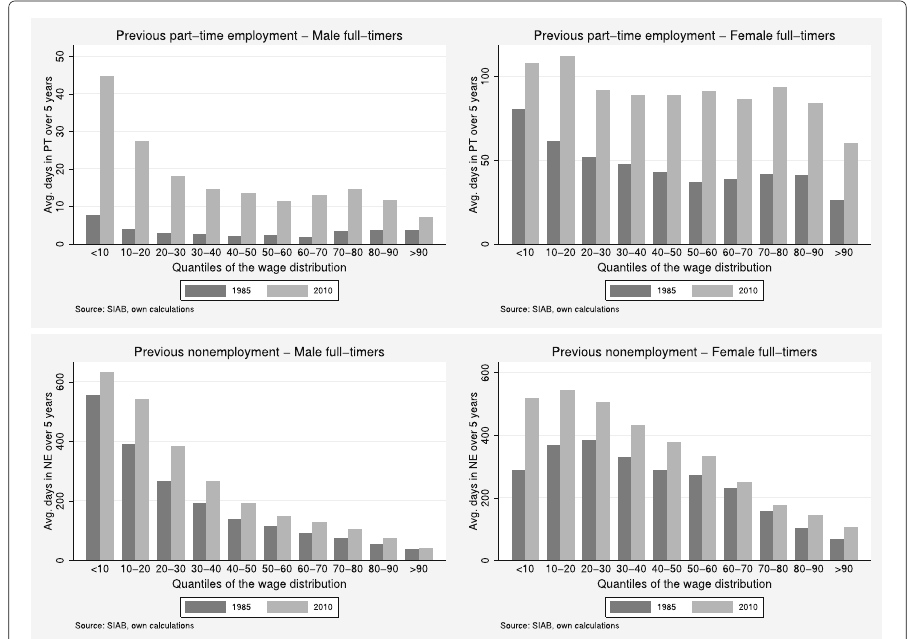
Fig. 1 Part-time employment and nonemployment during the previous 5 years in different parts of the full-time wage distribution. Average number of days in part-time employment/nonemployment during the years 1980–1984 and 2005–2009, respectively, by decile of the full-time wage distribution in the years 1985 and